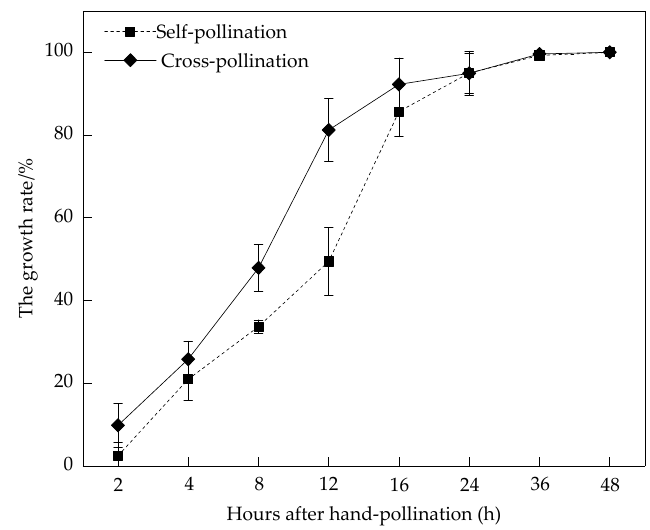
Figure 5. The pattern of pollen tube growth in the styles of Schima superba under two pollination treatments (S.E.)